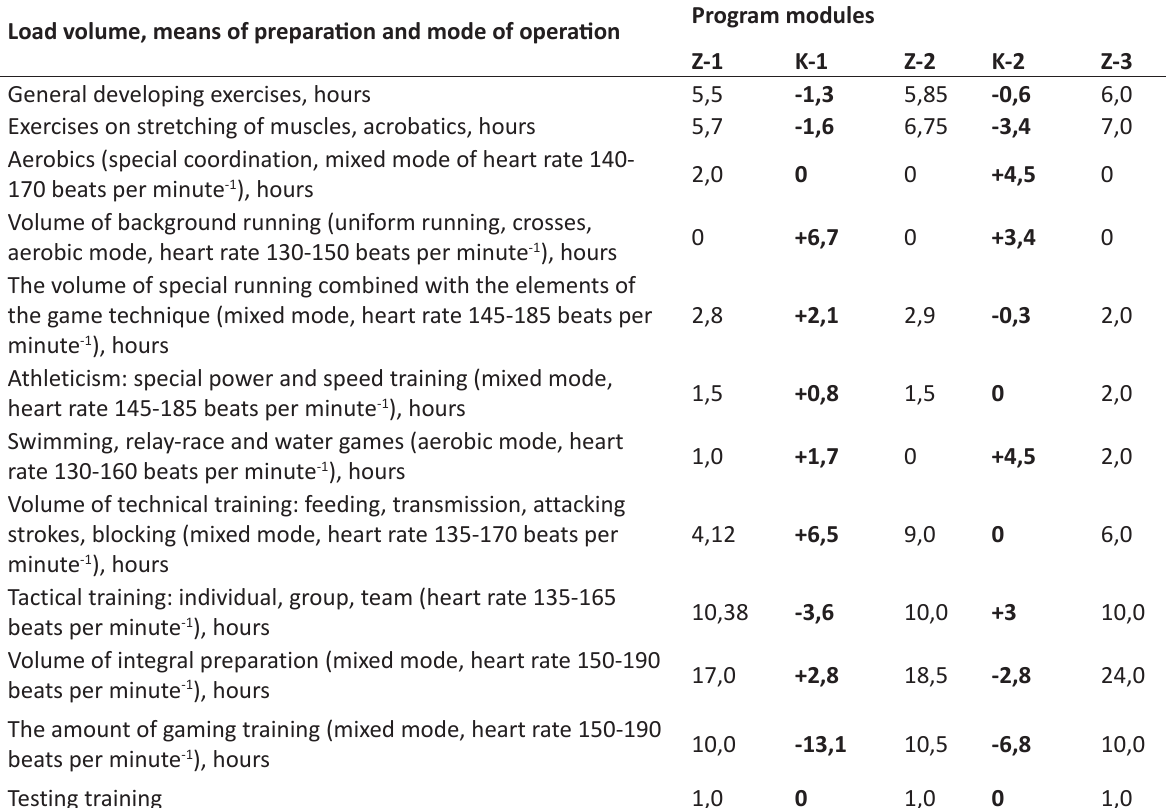
Table 1. Experimental program of planning training sessions in the competitive period of the annual cycle of training for women’s volleyball team of higher